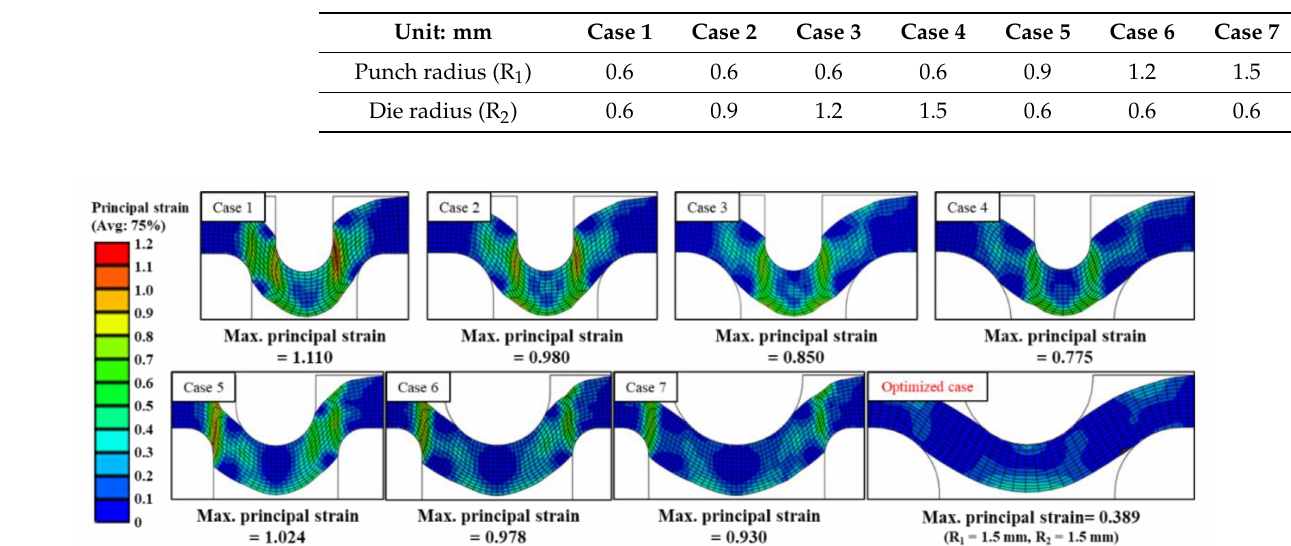
Figure 9. Simulation results for design variables in preforming process for the target sheet.